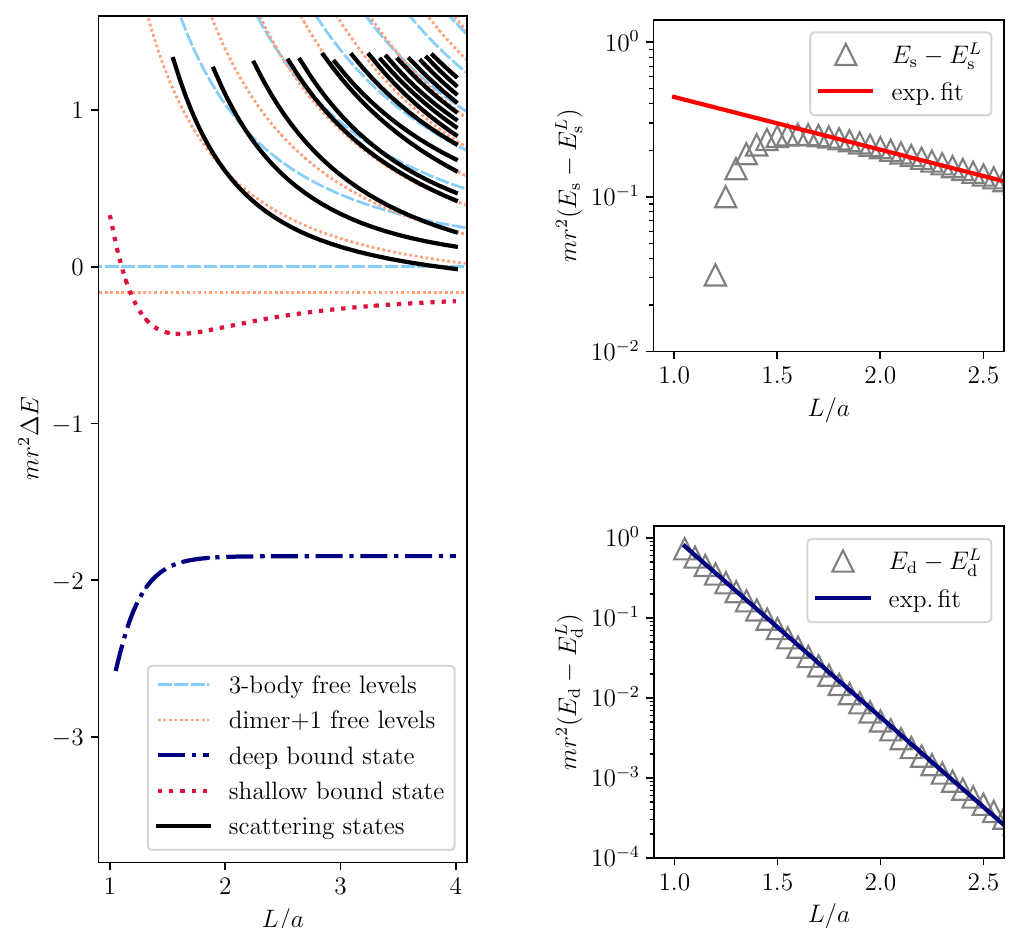
Figure 1 . Left panel: finite-volume three-particle spectrum of the Yamaguchi model for different values of L . Both scattering states and bound states are shown. For comparison, we also display the free three-particle and particle-dimer levels in a finite volume. Right panel: finite-volume correction to shallow and deep bound state energies. The results of the exponential fit are also shown. For explanation of symbols and lines see